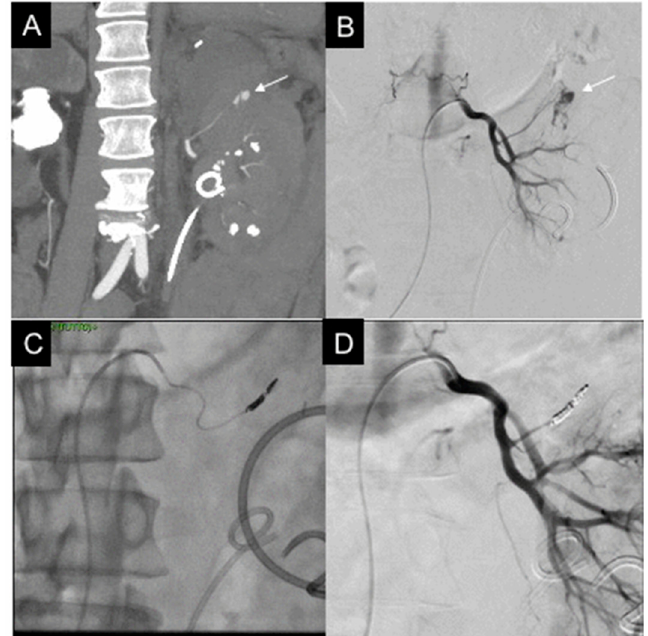
Figure 3. 50-year-old male, affected by iatrogenic active bleeding. ( A ) CT reconstruction with MIP and coronal MPR, in arterial phase: intraparenchymal active bleeding (white arrow) at the superior third of the left kidney; homolateral urological stent is evident. ( B ) Selective left renal DSA confirms active bleeding (white arrow). ( C ) Superselective microcatheterization and embolization with two detachable coils (Concerto 4 mm × 8 cm). ( D ) Final DSA showing active bleeding resolution, renal parenchyma